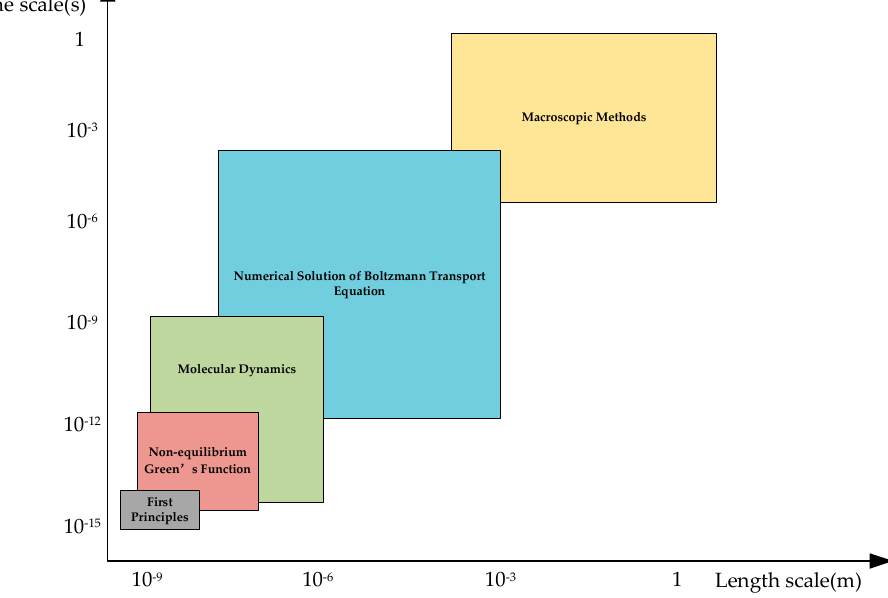
Figure 3. Approximate length and time scales for the commonly used computational methods.